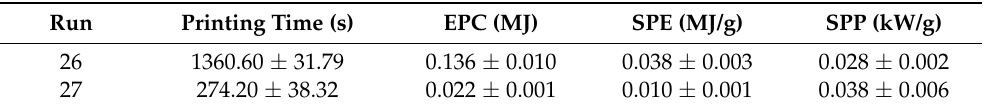
Table 10. Average and standard deviations values of measured responses for printing time, EPC, SPE, and SPP, for the confirmation runs.